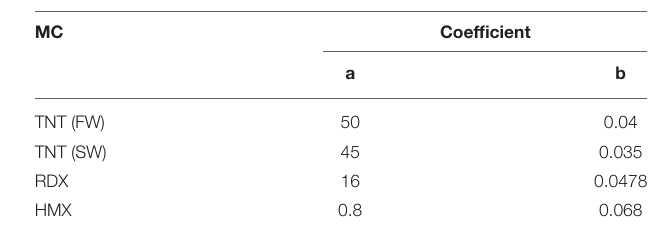
TABLE 2 | Coefficients for exponential fits of MC solubility as a function of temperature ( Figure 4 ).